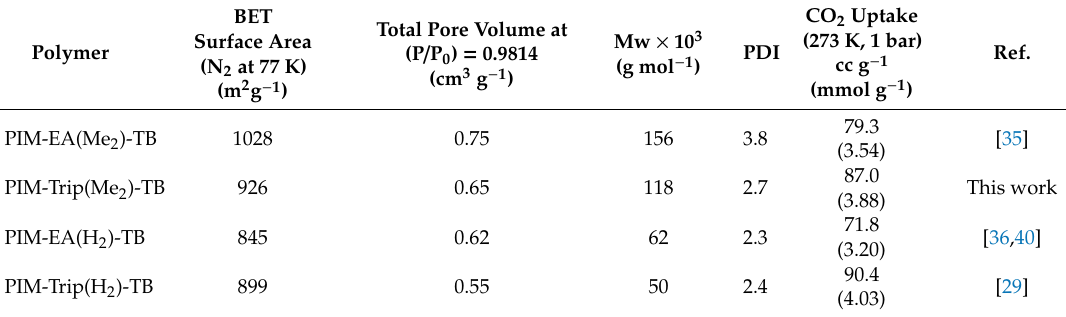
Table 1. Summary of the physical properties of TB-PIMs